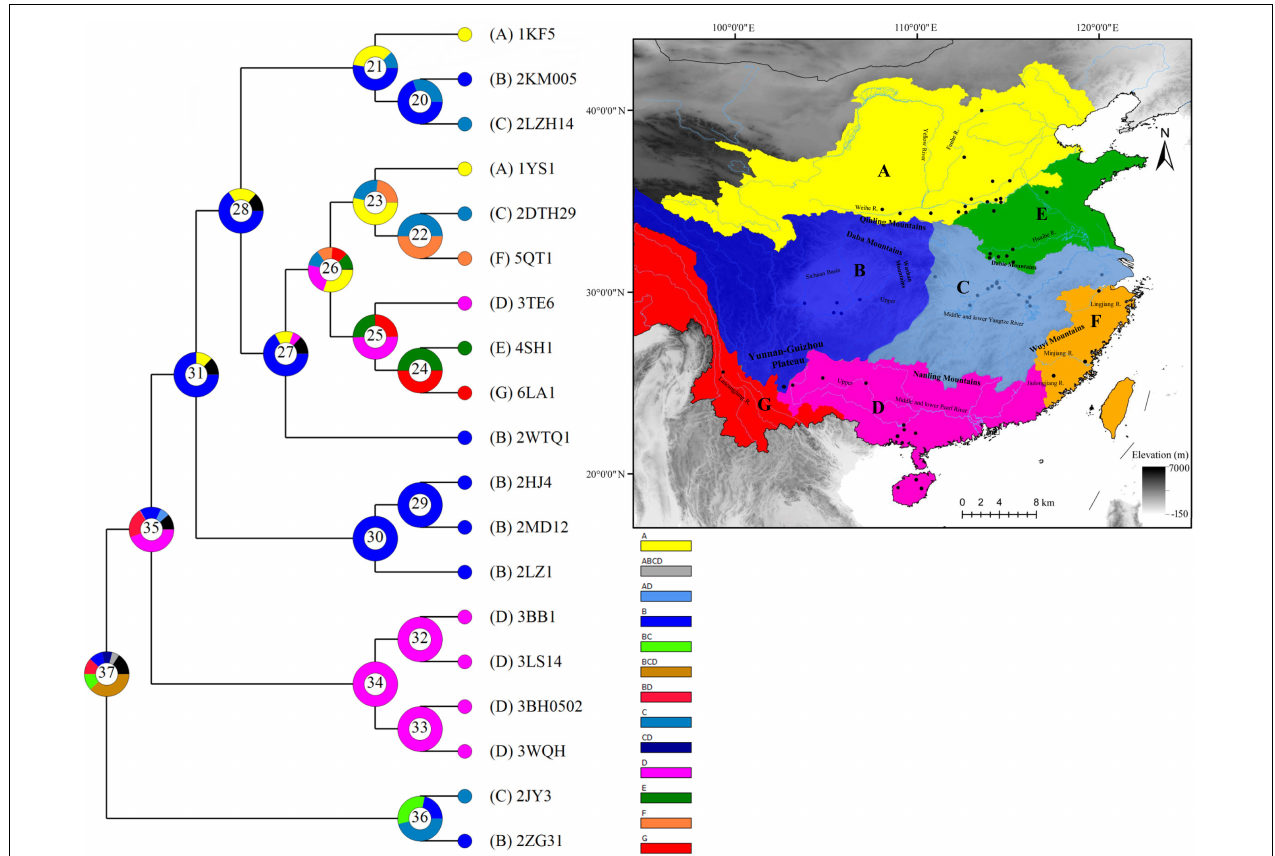
FIGURE 4 | Ancestral range reconstruction for the H. leucisculus across different river systems using 19 sequences of cytb. The colors of the charts correspond to the most likely ancestral areas inferred, and the black color means the unknown area. Letters represent the biogeographic regions for H. leucisculus : (A) the Yellow River basin, (B) the upper Yangtze River basin, (C) the middle and lower Yangtze River basin, (D) the Pearl River basin, (E) the Huaihe River basin, (F) the river basin of southeastern, and (G) the river basin of southwestern. The blue curves mean the river